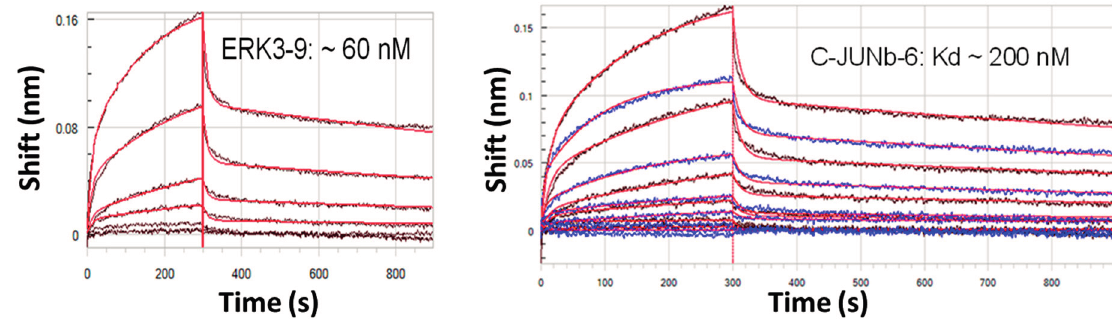
Figure 1. Inverted “convex” interferometer scans of 200 base DNA aptamers binding small cancer biomarker peptides. The unprocessed curves (not shown) are “concave” due to blue-shifting of the smaller bound aptamer-peptide complex as compared to the larger free aptamer without its captured peptide. This phenomenon strongly suggests an induced fit binding mechanism with longer